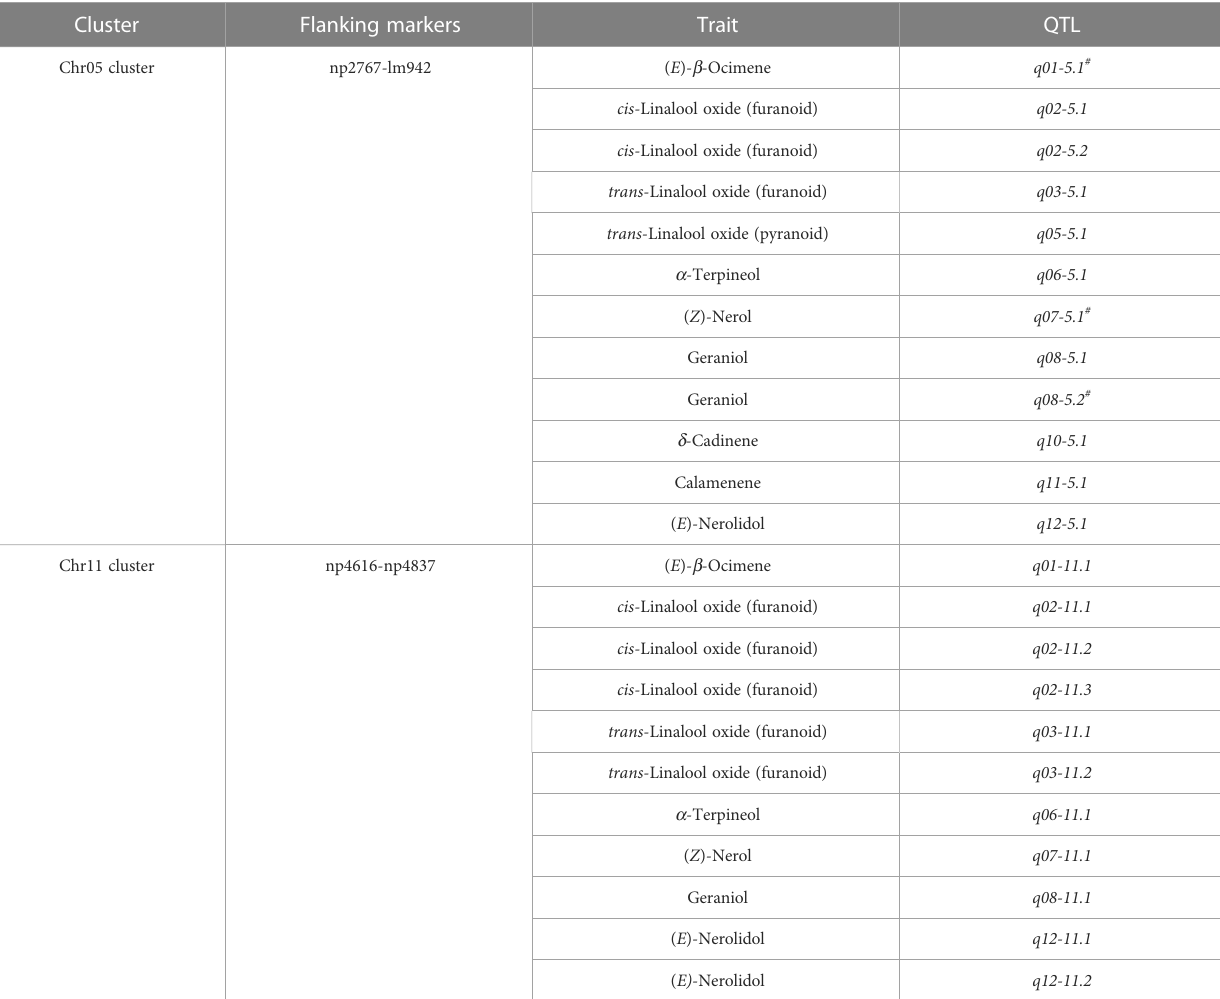
TABLE 4 QTL Clusters for volatile terpene contents in the ‘ HD ’ × ‘ JX ’ F 1 population.